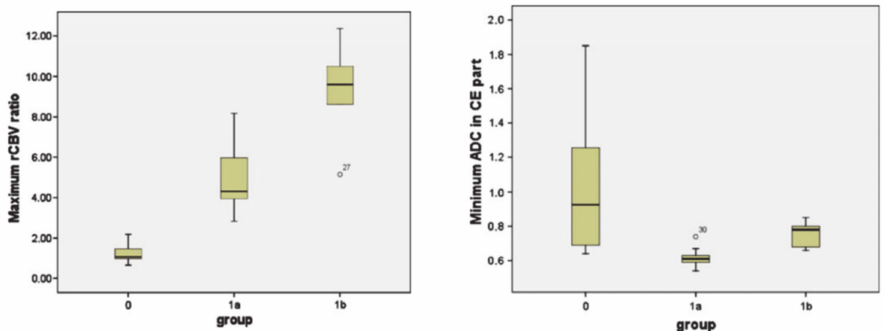
Figure 8. Box-and-whisker plots demonstrating the distributions of maximum relative cerebral blood volume (rCBV) ratios (left panel) and minimum ADC (right panel) from three groups (group 0: patients who remained stable during the follow-up period; group 1a: patients who were suspected but not confirmed with TP; group 1b: patients who were definitive TP). The bottom and top edges of boxes represent the 25th percentile and the 75th percentile values. The bands within the boxes represent 50th percentile (median) values. Whiskers display the range of data distribution. Outliers are marked with open circles. Reprinted with permission from ref. [110]. Copyright 2010